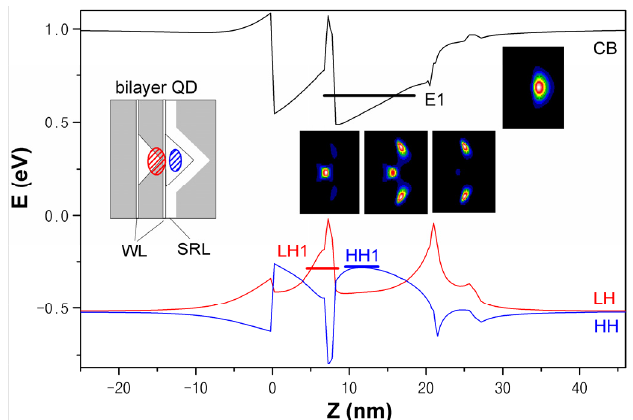
Figure 2. Band structure of bilayer QD as schematized (WL: wetting layer). Insets: ground-state wavefunctions.